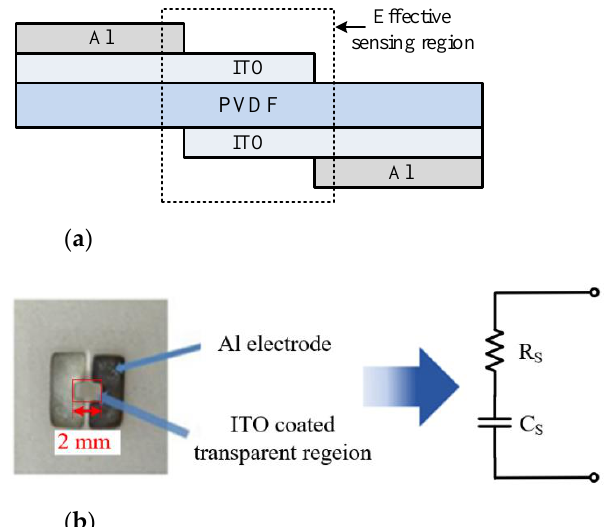
Figure 1. ( a ) Schematic diagram of the PVDF transducer; ( b ) photograph of the PVDF transducer and its electrical model.